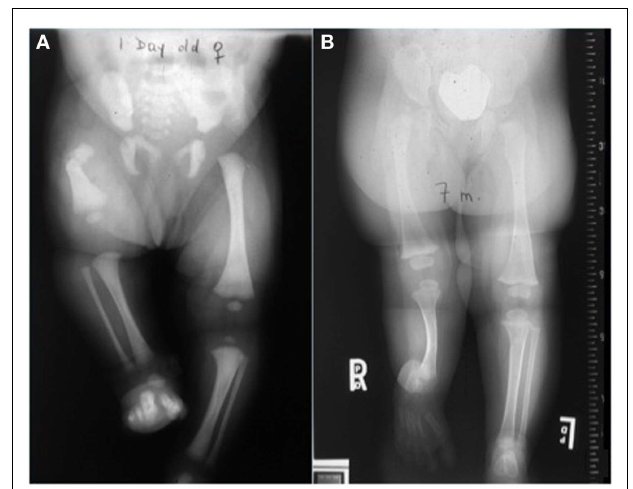
FIGURE 3 | Distraction osteogenesis is used to manage multiple orthopedic conditions including congenital short femur (A) and fibular hemimelia (B) .